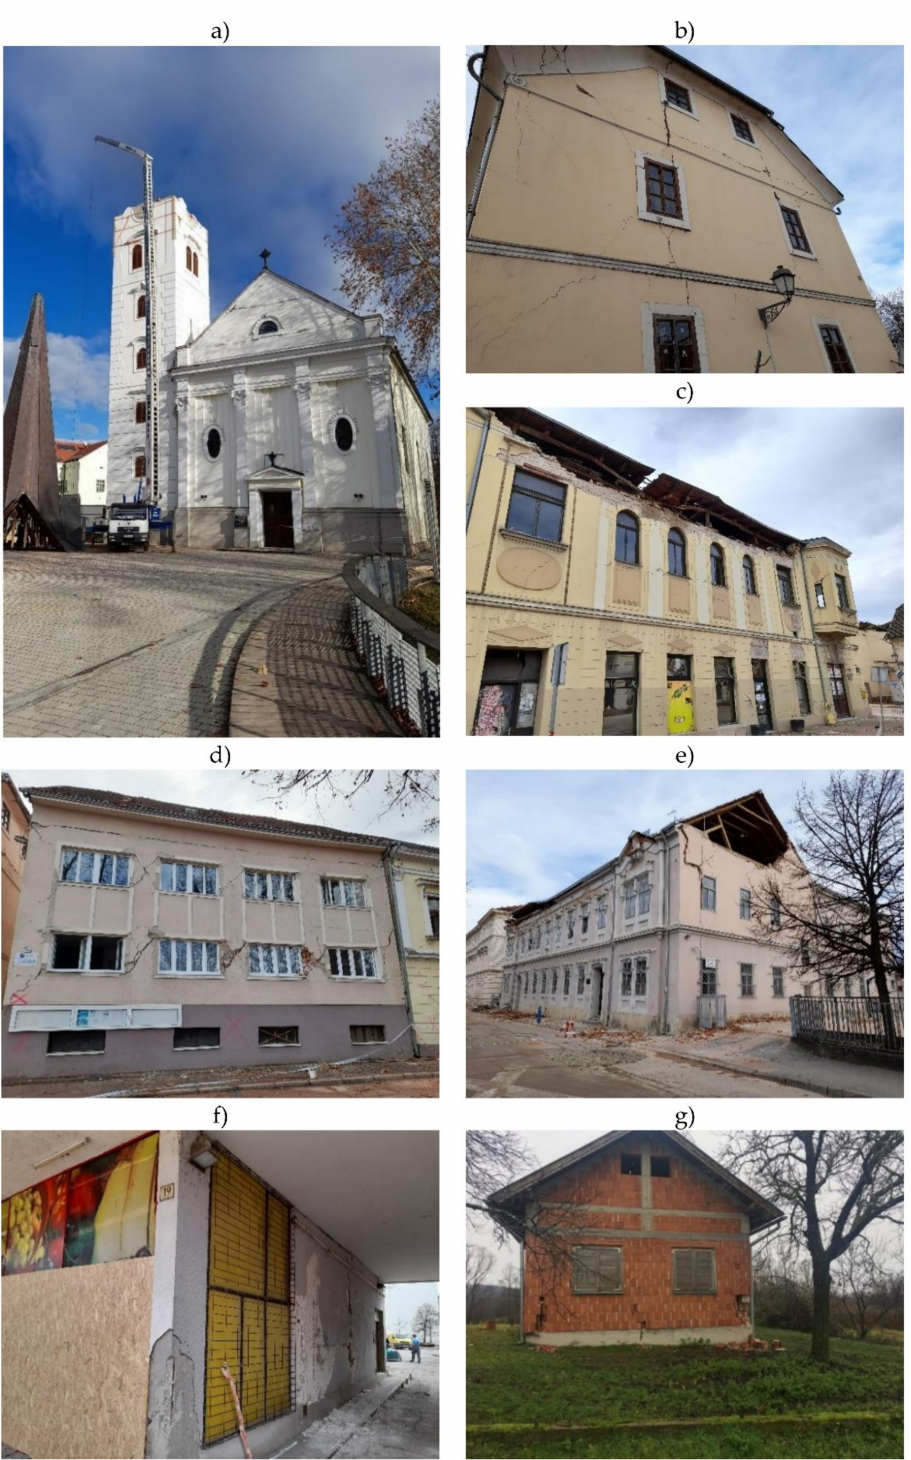
Figure 11. Damages that were sustained by various building types built in the pre-code era (before 1964) and in various code eras: ( a ) The Cathedral of the Exaltation of the Holy Cross in Sisak with the tower roof removed; ( b ) Crack distribution in an old masonry building in Petrinja; ( c ) Parapet wall collapse in an old masonry building in Petrinja; ( d ) Masonry pier diagonal tension cracking; ( e ) Gable wall out-of-plane collapse in an elementary school in Petrinja; ( f ) Damage to the masonry-infilled RC frame (soft storey collapse); and ( g ) Damage to a building that was built without vertical confining elements as part of a rebuilding programme in the post-war era [58] (author of all photos: D.